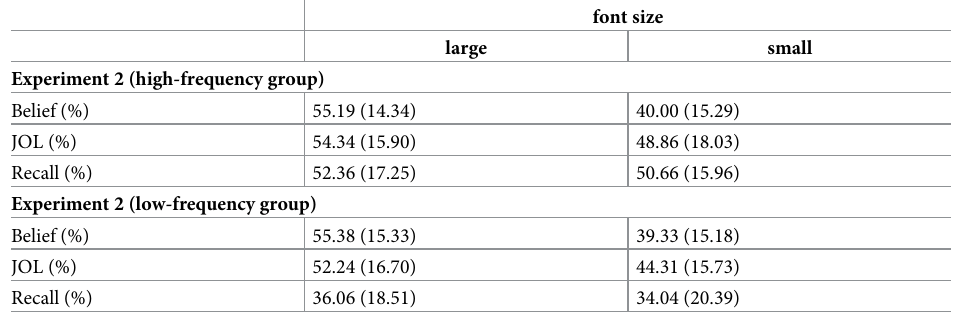
Table 3. Means ( SDs ) for belief-based predictions, JOLs, and recall performance in Experiment 2.